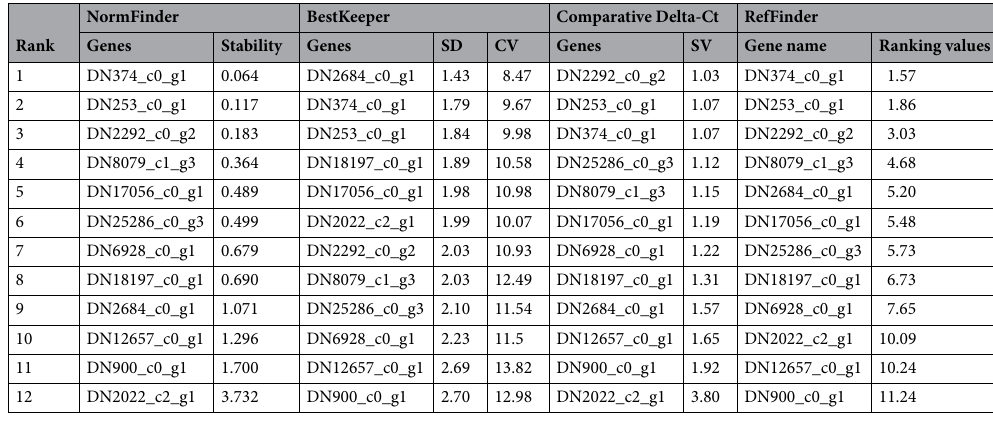
Table 2. Ranking of the candidate reference genes using NormFinder, BestKeeper, Comparative Delta Ct, and RefFinder